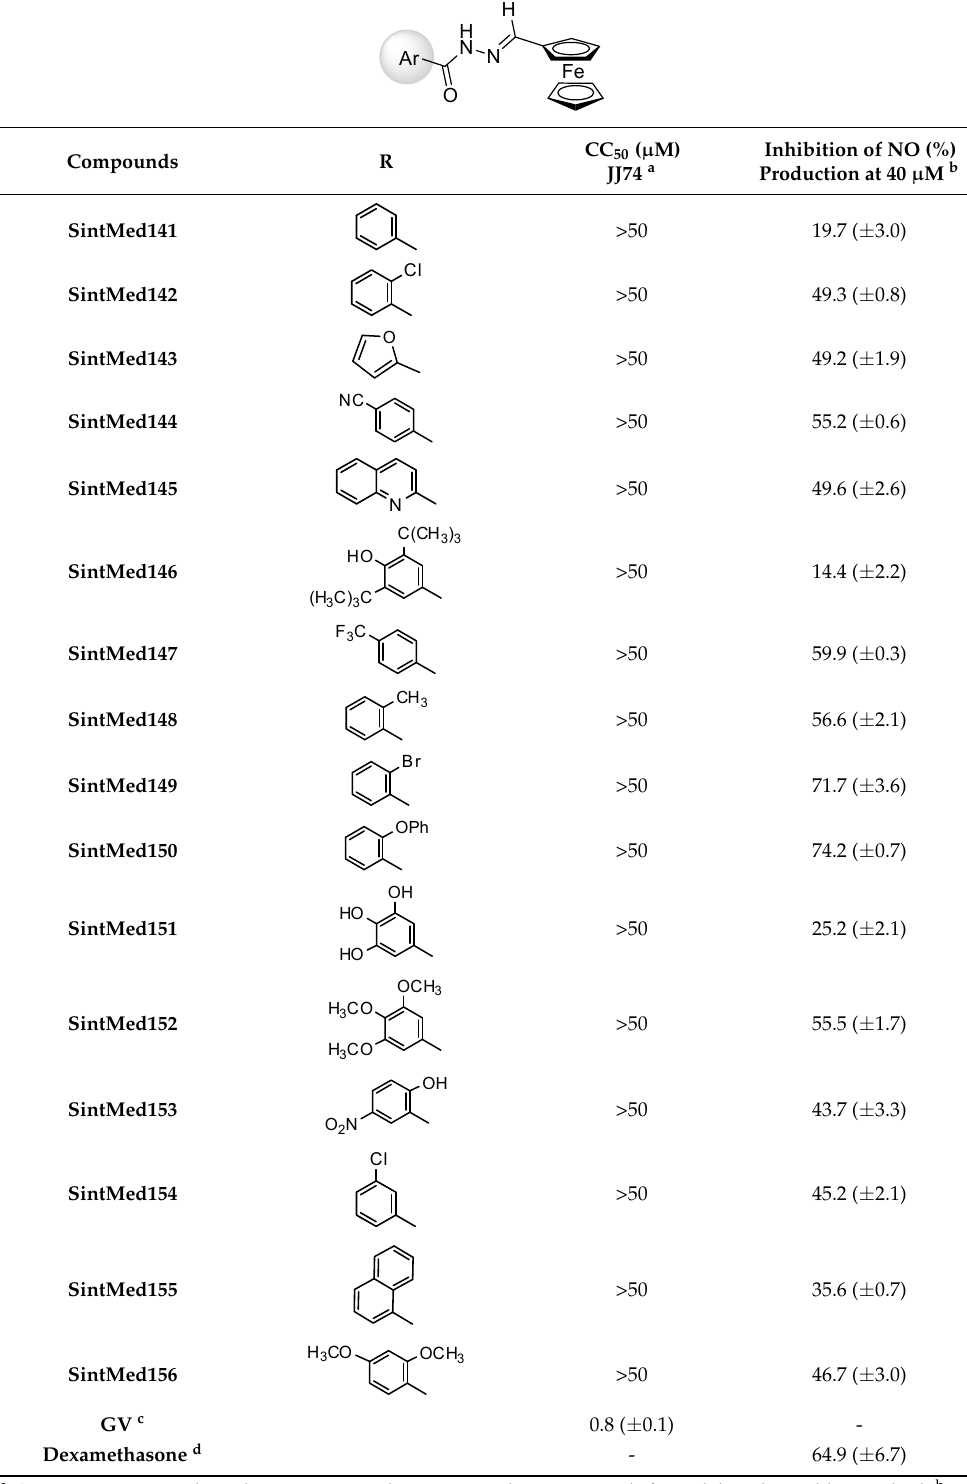
Table 1. Cytotoxicity and inhibitory effect on nitric oxide production of Fc-NAH SintMed ( 141 – 156 ).